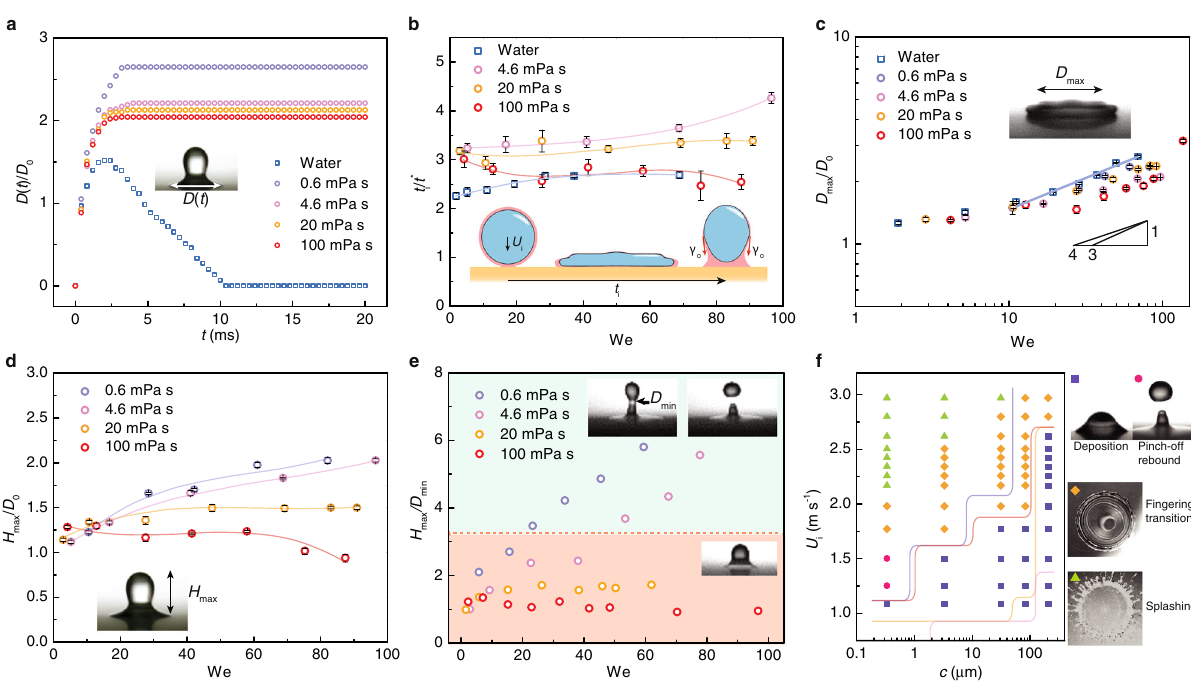
Fig. 2 Deposition dynamics. a The temporal evolution of the normalized contact lengths of impacting droplets ( D 0 = 2.0 mm, U i = 0.7 m s − 1 , c = 60 μ m). Silicone oils are used as overlayers. b The normalized impact time appears to be weakly dependent upon the Weber number and decreases as the overlayer q ffiffiffiffiffiffiffiffiffiffiffiffiffiffi ρ R 3 = γ viscosity increases. t * is the characteristic contact time, t (cid:3) ¼ , where R 0 is the droplet radius and subscript k is d for pure water and d/o for k 0 overlaid water. Solid lines are drawn to aid the visualization. Insets are schematics showing the spreading and receding of an impacting droplet. Error bars denote the standard deviation over fi ve experiments. c The normalized maximum spreading diameters share a similar slope but decrease as the viscosity increases for We > 10. The purple line is the linear fi tting line for pure water with a slope of 0.28. Error bars denote the standard deviation over fi ve experiments. d The normalized maximum out-of-plane height as a function of the Weber number. Solid lines are drawn to aid the visualization. Error bars denote the standard deviation over fi ve experiments. e The maximum aspect ratio of droplets after receding as a function of the Weber number. The green and red regions denote deposited and pinch-off rebounding droplets, respectively. The red dashed line denotes the threshold value above which pinch-off occurs. c = 59 μ m for ( b – e ). f Phase diagram of a water droplet overlaid with 100-mPa s silicone oil. Markers show the experimental outcome after impact (purple squares: deposition, magenta circles: pinch-off rebound, orange diamonds: fi ngering, transition and green triangles: splashing) as a function of the impact velocity and overlayer thickness. Purple, red, orange and pink solid lines denote the boundary of deposition for the overlayer with viscosities of 500, 100, 20 and 4.6 mPa s, respectively. Phase diagrams of water droplets overlaid with 500, 20 and 4.6-mPa s silicone oils are shown in Supplementary Fig.